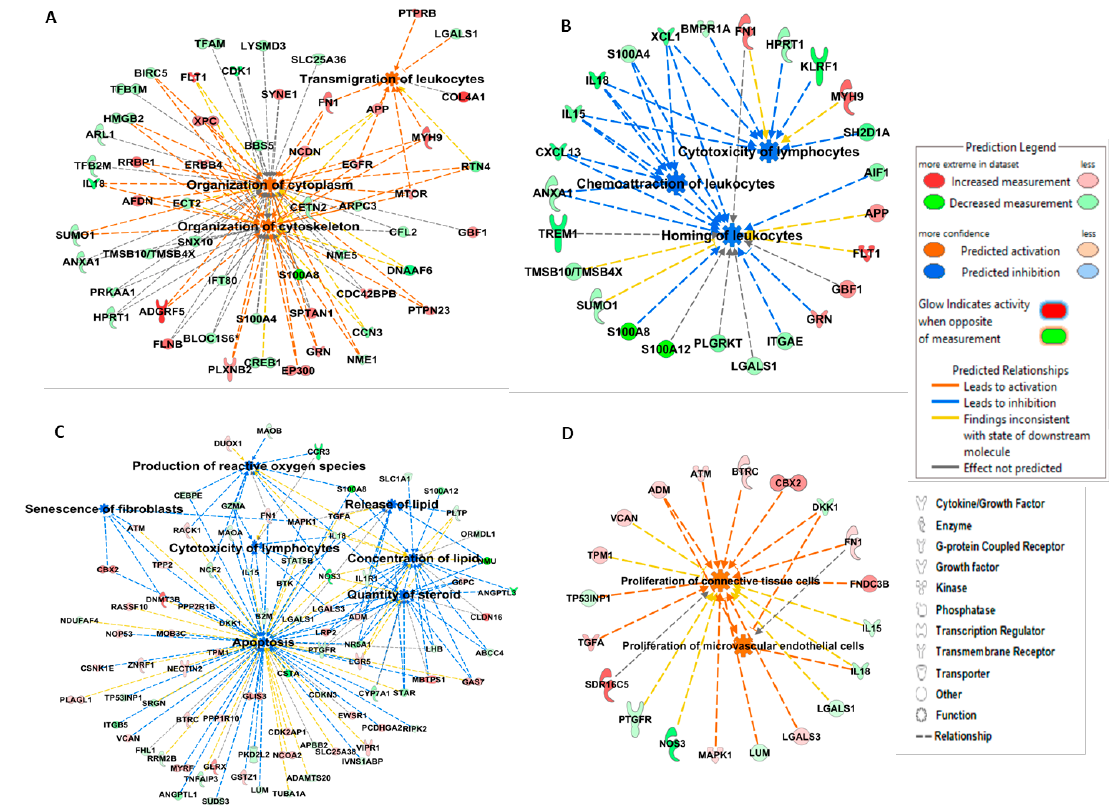
Figure 3. IPA depicting networks integrating DEGs identified on 6DP as compared to 6DC in ( A ) activated functions: organization of cytoskeleton, organization of cytoplasm, and transmigration of leukocytes, and ( B ) inhibited immunological functions: cytotoxicity of lymphocytes, chemoattraction of leukocytes, and homing of leukocytes. DEGs identified that 6DPI as compared to 6DC were found to be associated with ( C ) activated functions: proliferation of connective tissue cells and proliferation of microvascular endothelial cells and ( D ) inhibited functions: cytotoxicity of lymphocytes, apoptosis, production of reactive oxygen species, concentration and release of lipid and quantity of steroid, on Day 6 after SP infusion in the porcine endometrium. Red and green colors depict an increase or decrease, respectively, in the expression of a gene. The color intensity of nodes indicates a fold change increase or decrease associated with a particular